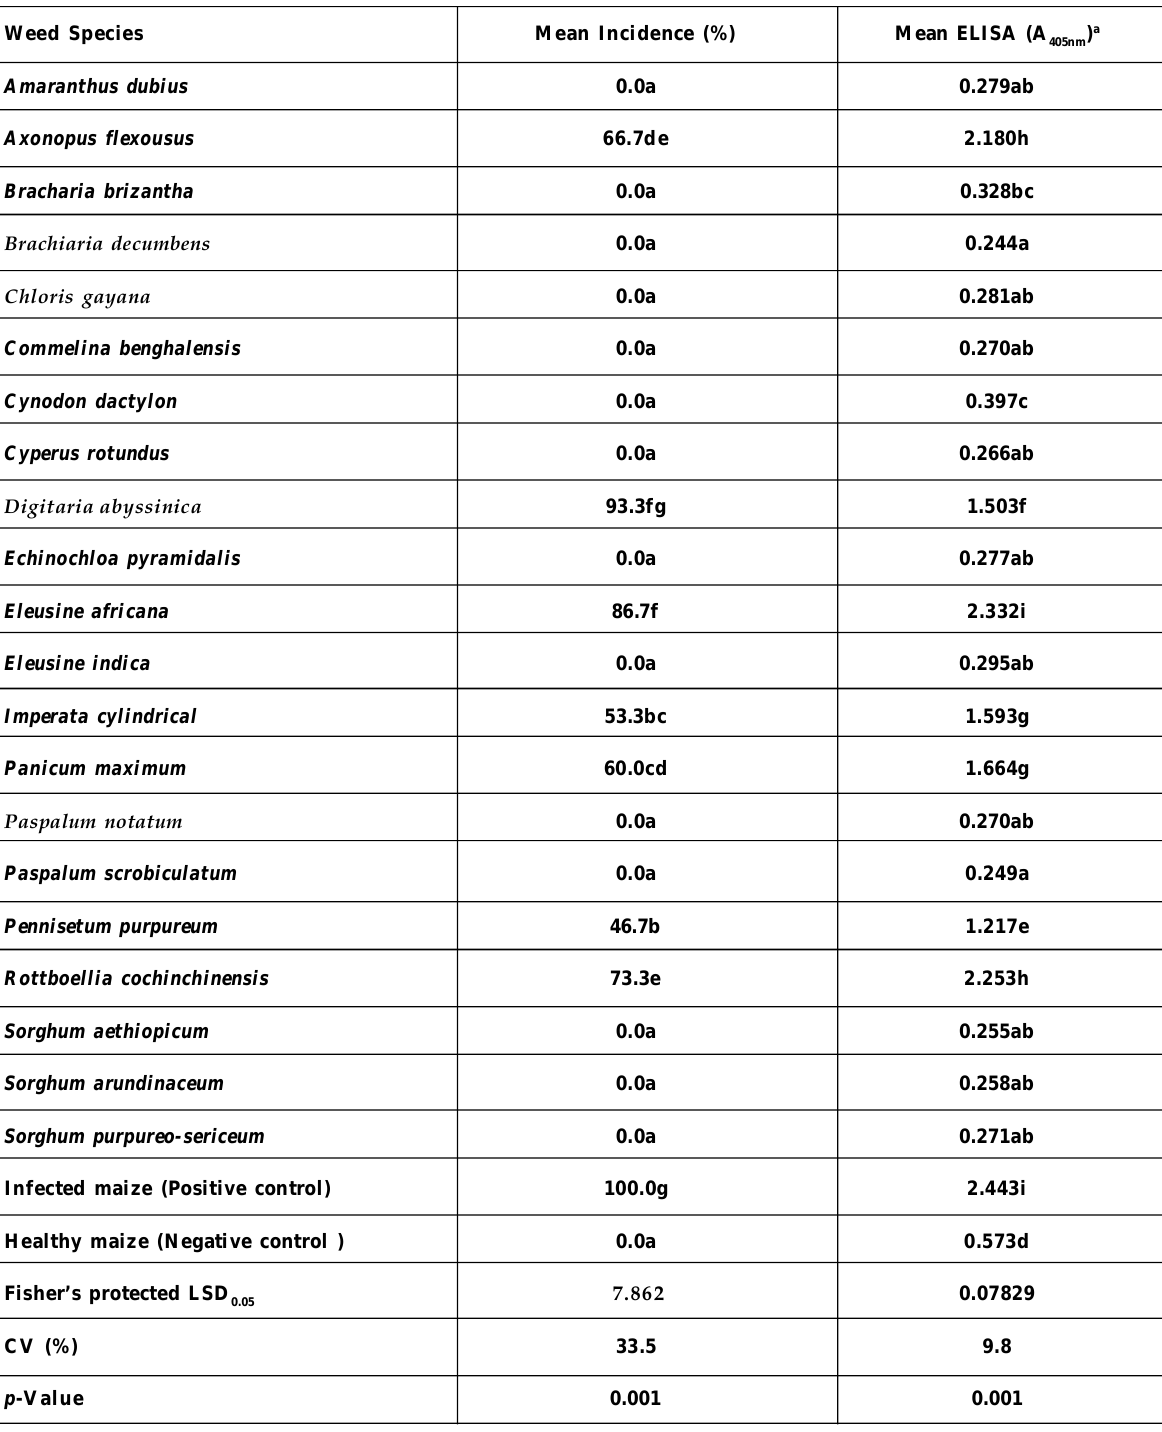
Table 3: Susceptibility of weed species to MCMV after mechanical inoculation with MLN Weed